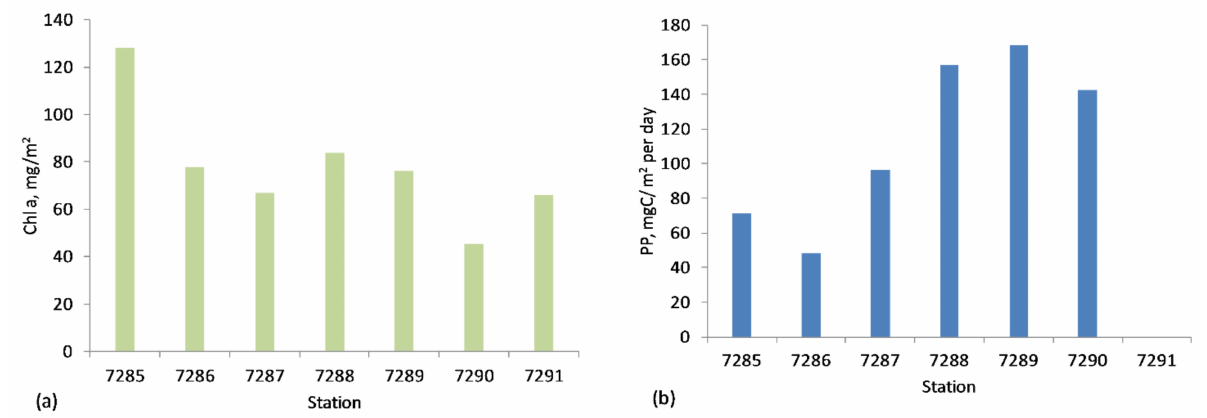
Figure 12. Distribution of the total content of chlorophyll “a” (determined by the extract method) ( a ) and the integral primary production ( b ) in the euphotic layer in the section.